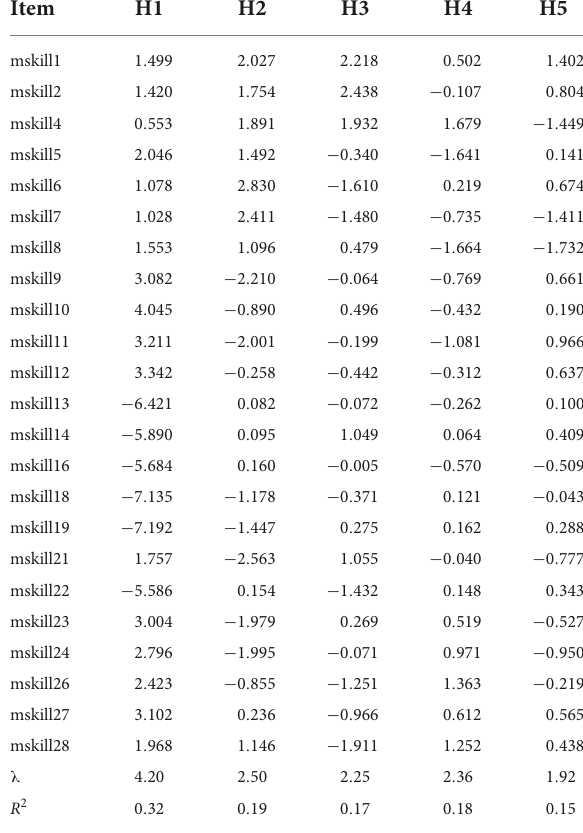
TABLE 2 Principal components (H), eigenvalues ( λ ), and percentage of common variance explained (R2)—main components with disturbing ones